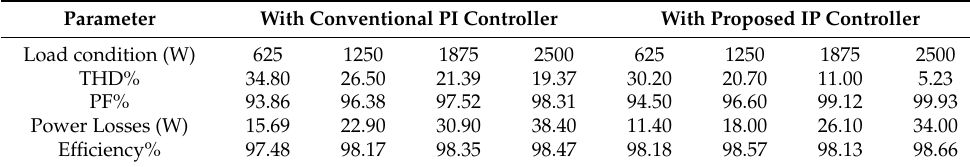
Table 2. Performance of the designed CCM-PFC with different loading conditions.